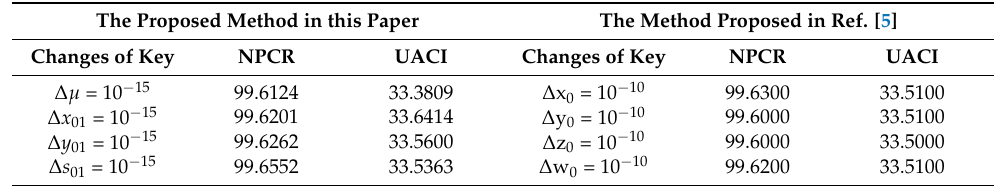
Table 8. Sensitivity of our proposed method with only one key change 10 − 15 .